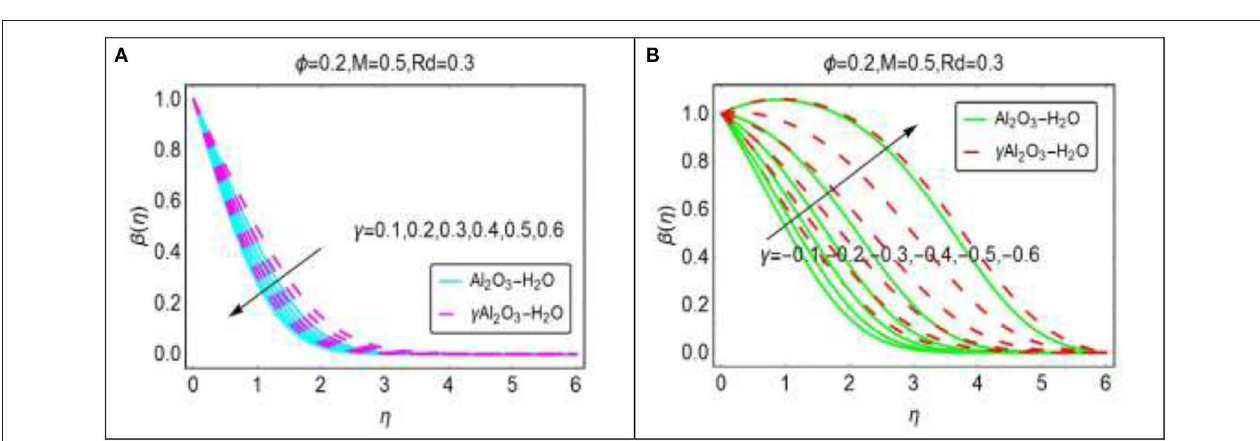
FIGURE 6 | The effects of (A) γ positive, (B) γ negative on dimensionless temperature β ( η ).